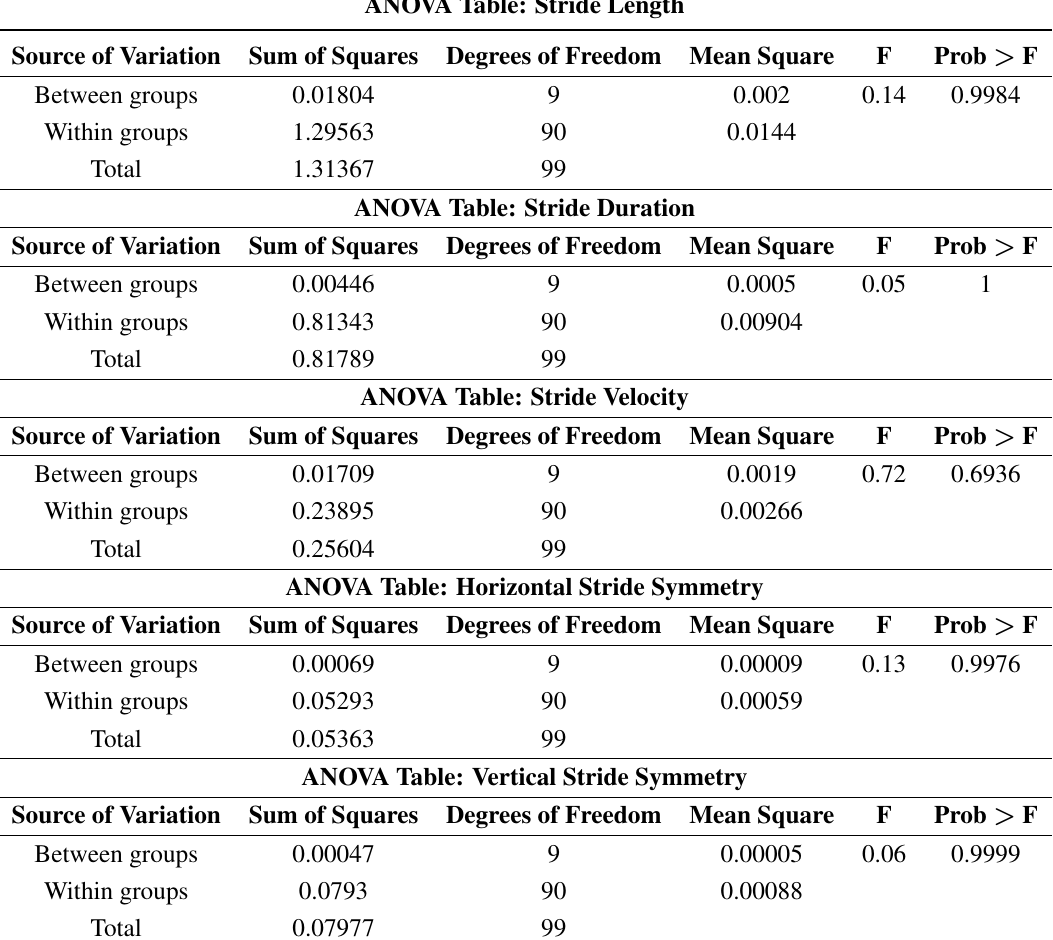
velocity, horizontal stride symmetry, and vertical stride